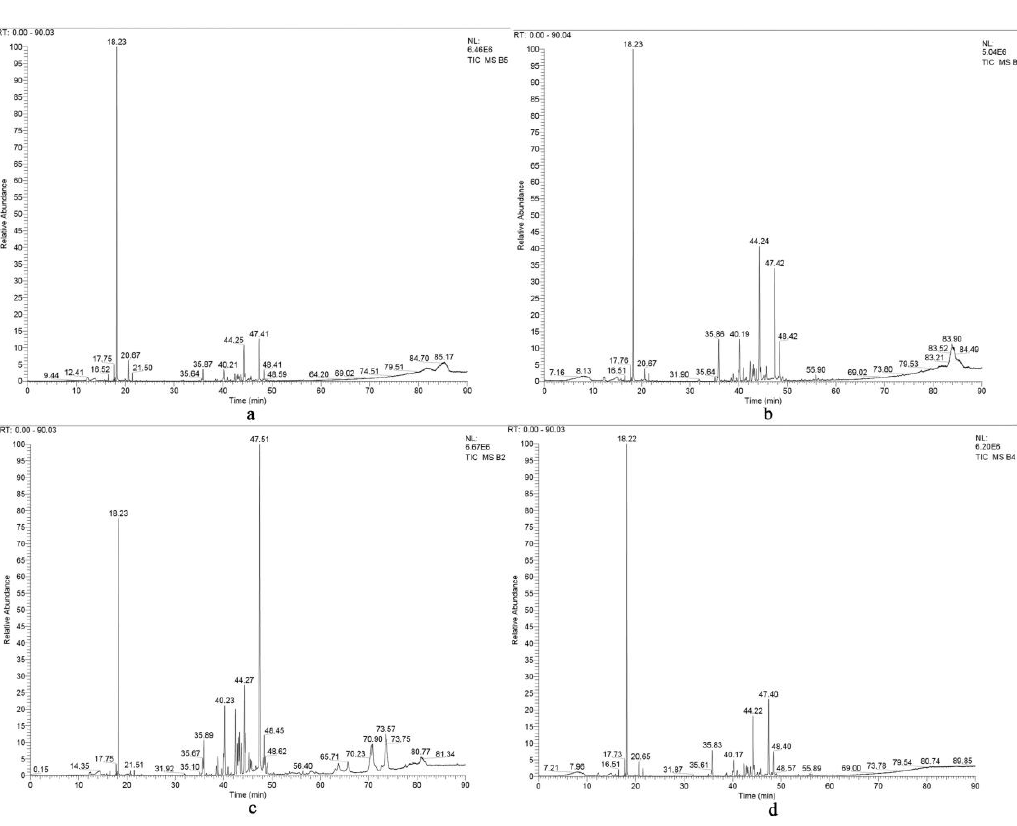
Figure A1. Total ion current diagram of P. notoginseng . Four-forked seven leaves ( a ), three-forked seven leaves ( b ), four-forked five–seven leaves ( c ), and three-forked five–six leaves ( d ).